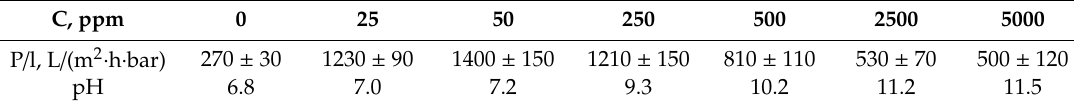
Figure 1. SEM micrographs of the fiber cross-section ( a ) with a zoomed-in view of the wall ( b , c ). Table 1. The dependence of the pure water permeance as a function of the active chlorine concentration (C) and pH value after treatment with the hypochlorite solution. “0” stands for the initial, untreated